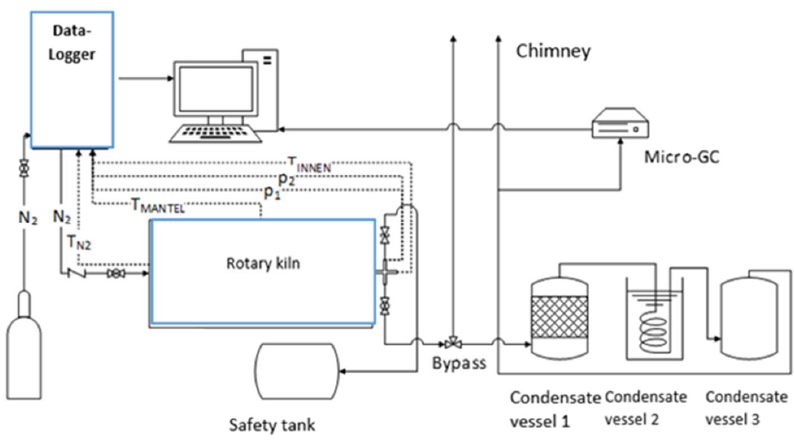
Figure 1. Schematic of the rotary kiln experimental set ‐ up. For each torrefaction test, 5 kg of the homogenized wood pellets were placed in the rotary kiln reactor. The flow rate of nitrogen was adjusted to 10 L/min while the rotary kiln speed was set to 5.6 rpm via the data logger. The experiment was started by heating